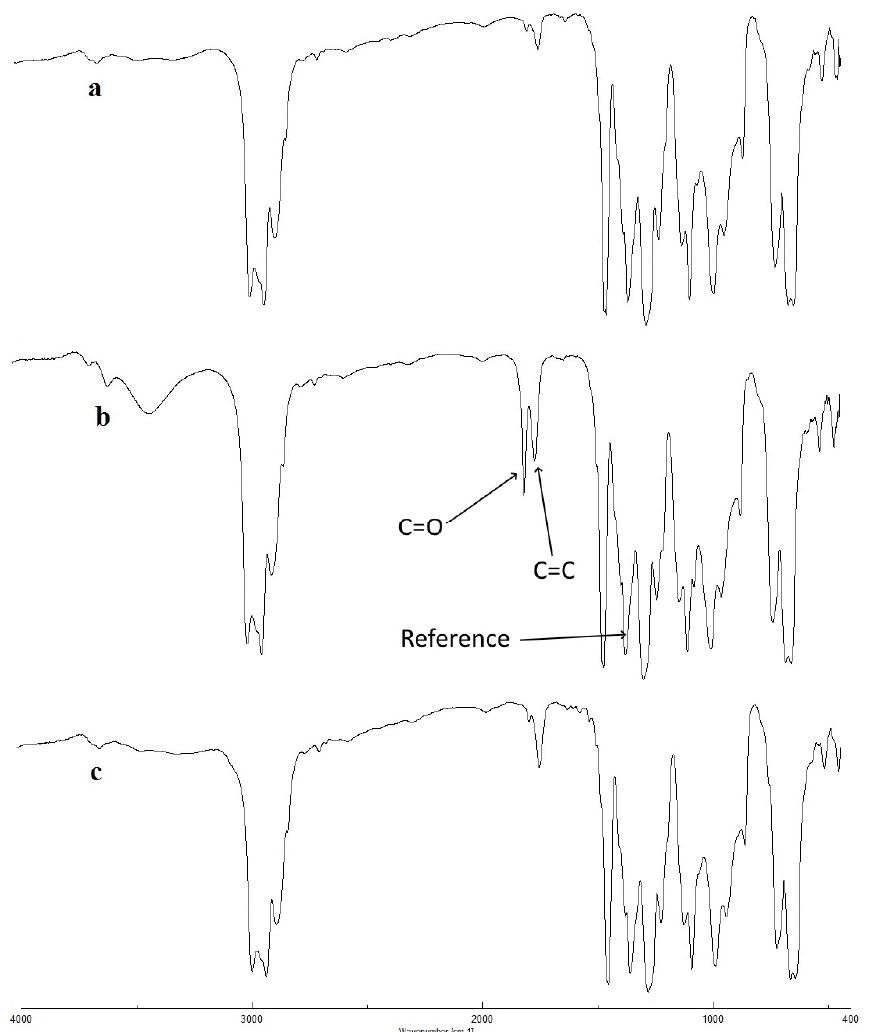
Figure 1. FTIR spectra of ( a ) blank poly(vinyl chloride) (PVC) before irradiation, ( b ) blank PVC after irradiation (300 h), and ( c ) PVC + 1 blend after irradiation (300 h).